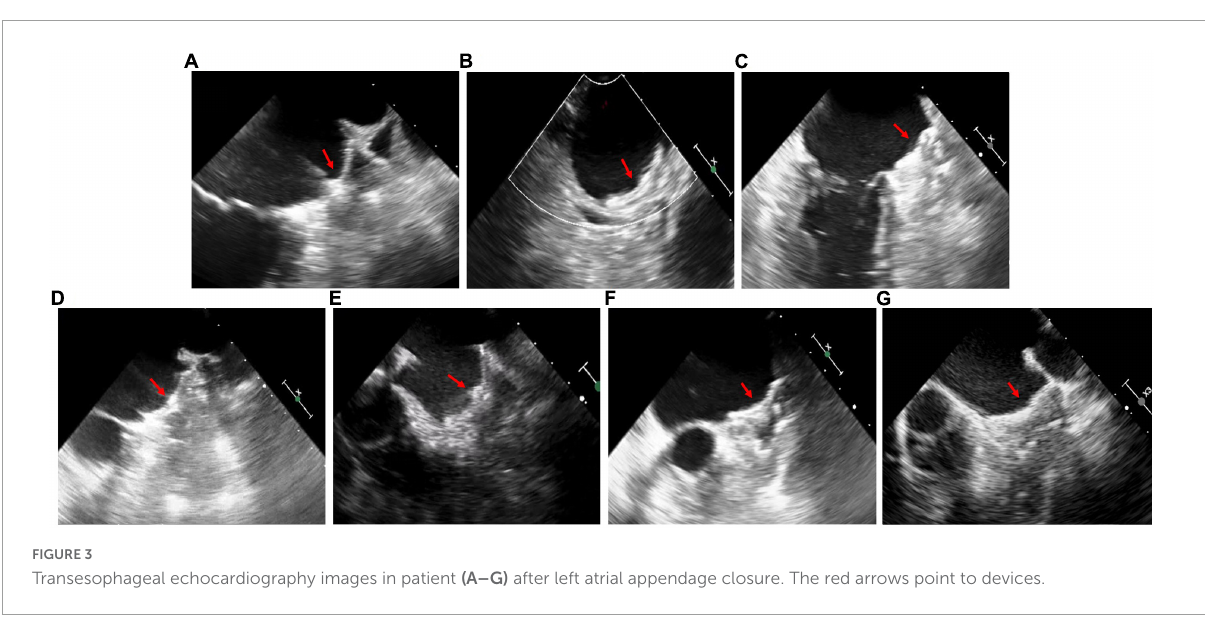
TABLE 2 Procedural